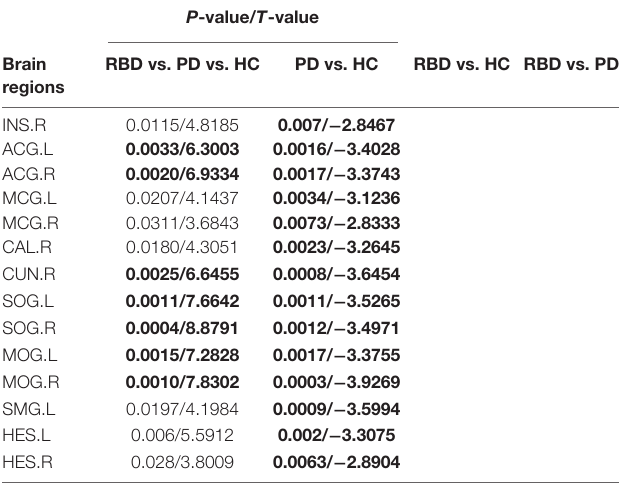
TABLE 2 | Alterations of degree centrality among iRBD, PD, and HC.